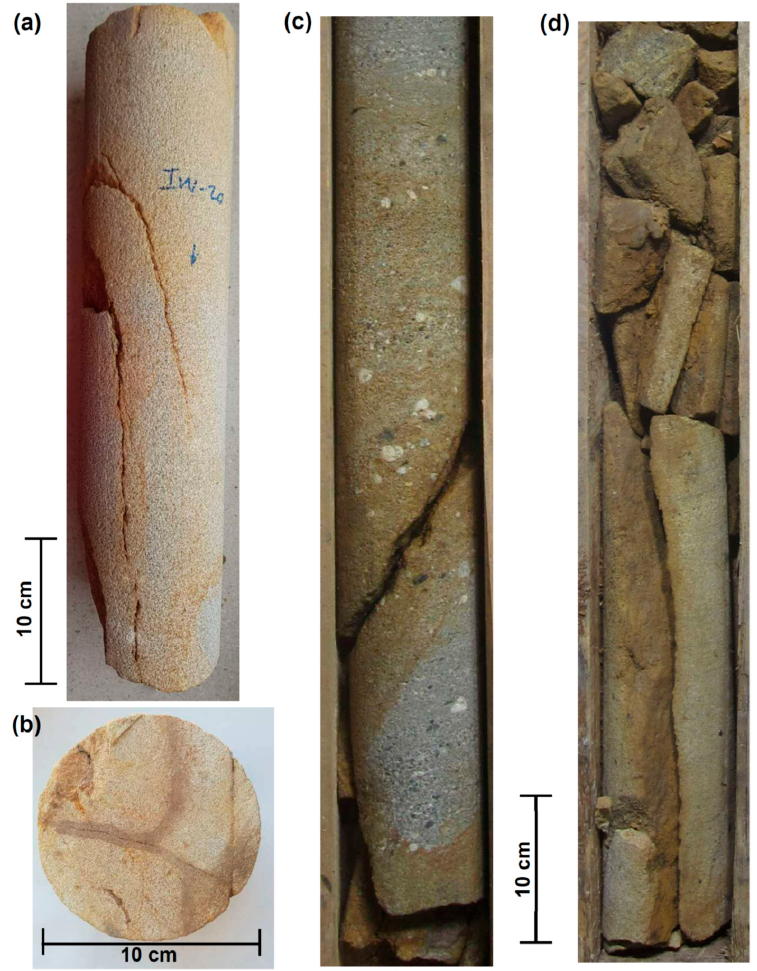
Figure 4. Types of breakups encountered during the core logging. ( a ) Longitudinal and ( b ) cross- sectional images of joint networks, displaying limited alteration zones. In both sections iron (oxide-) hydroxides hold the rock pieces together hindering fluid flow. ( c ) Sub-vertical fracture showing clear influence in the weathering state of the sandstone interval. ( d ) Cracked sandstone interval with a sub ‐ vertical fracture potentially associated with the exploitation of the Dickenberg coal seam, 4 m below it (this structure can be tracked on the core BK15 for approx. 5 m).